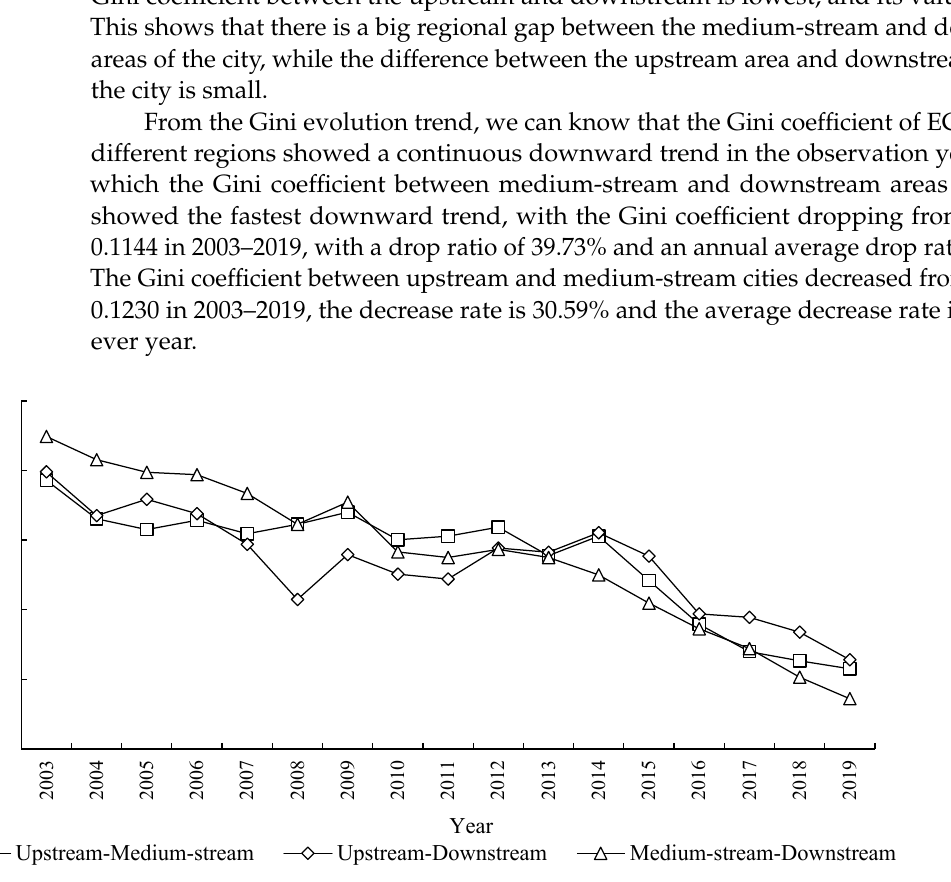
Figure 6. Inter-regional differences and evolution trend of ECP in the YRB.